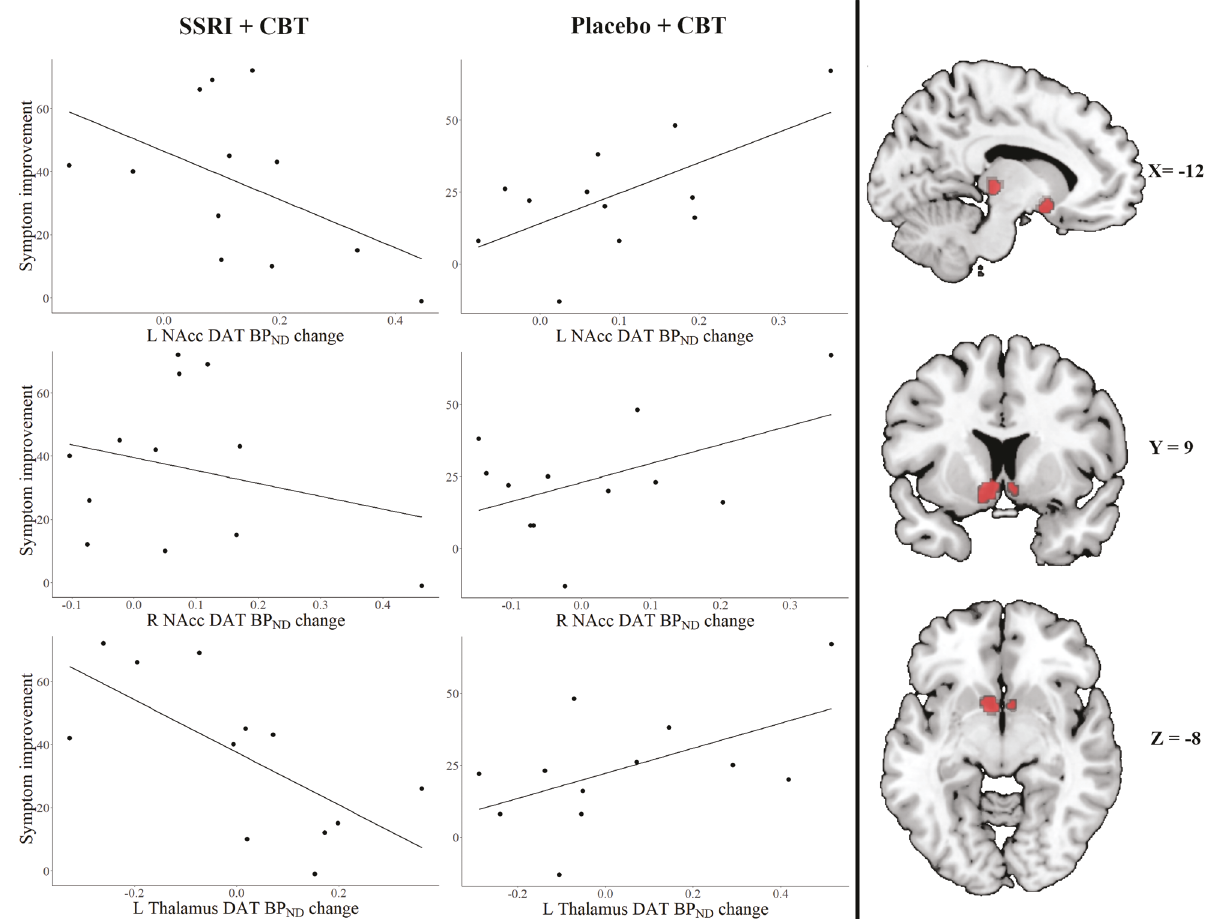
Fig. 3 Scatterplots of signi fi cant group differences in associations between symptom improvement, as measured with the Liebowitz Social Anxiety Scale (LSAS), and the percentage change in DAT BPND in the left nucleus accumbens (L NAcc), right NAcc (R NAcc) and left thalamus. Clusters of signi fi cant voxels ( P FWE < 0.05) shown overlaid on a standard anatomical brain